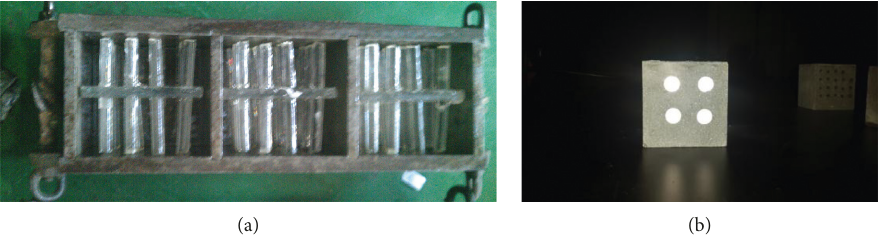
Figure 8: Resin light guide body.